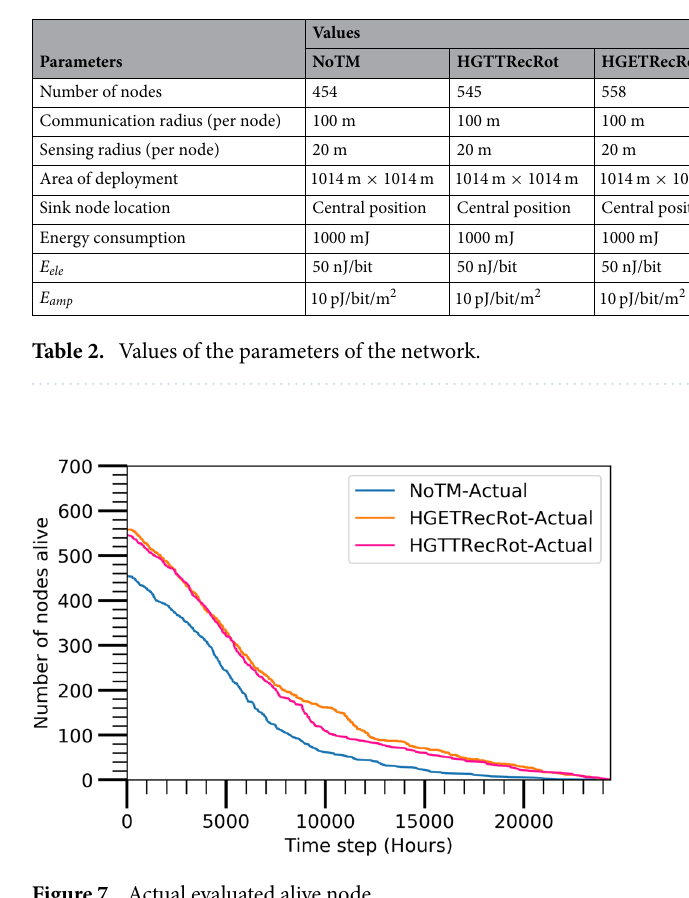
Figure 7. Actual evaluated alive node.